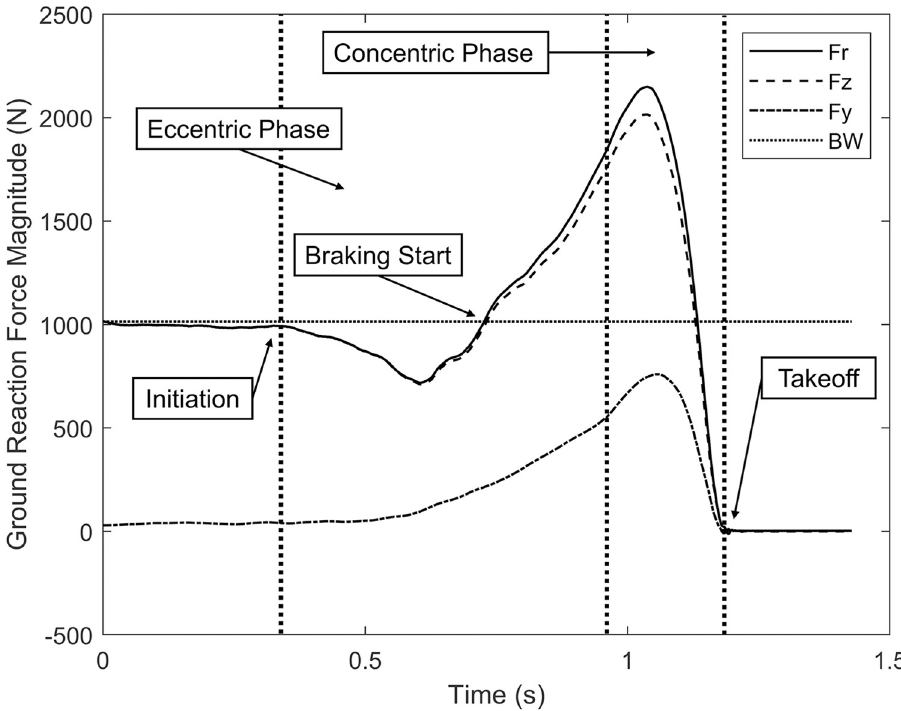
Fig 2. Example force vector plot. Phase boundaries